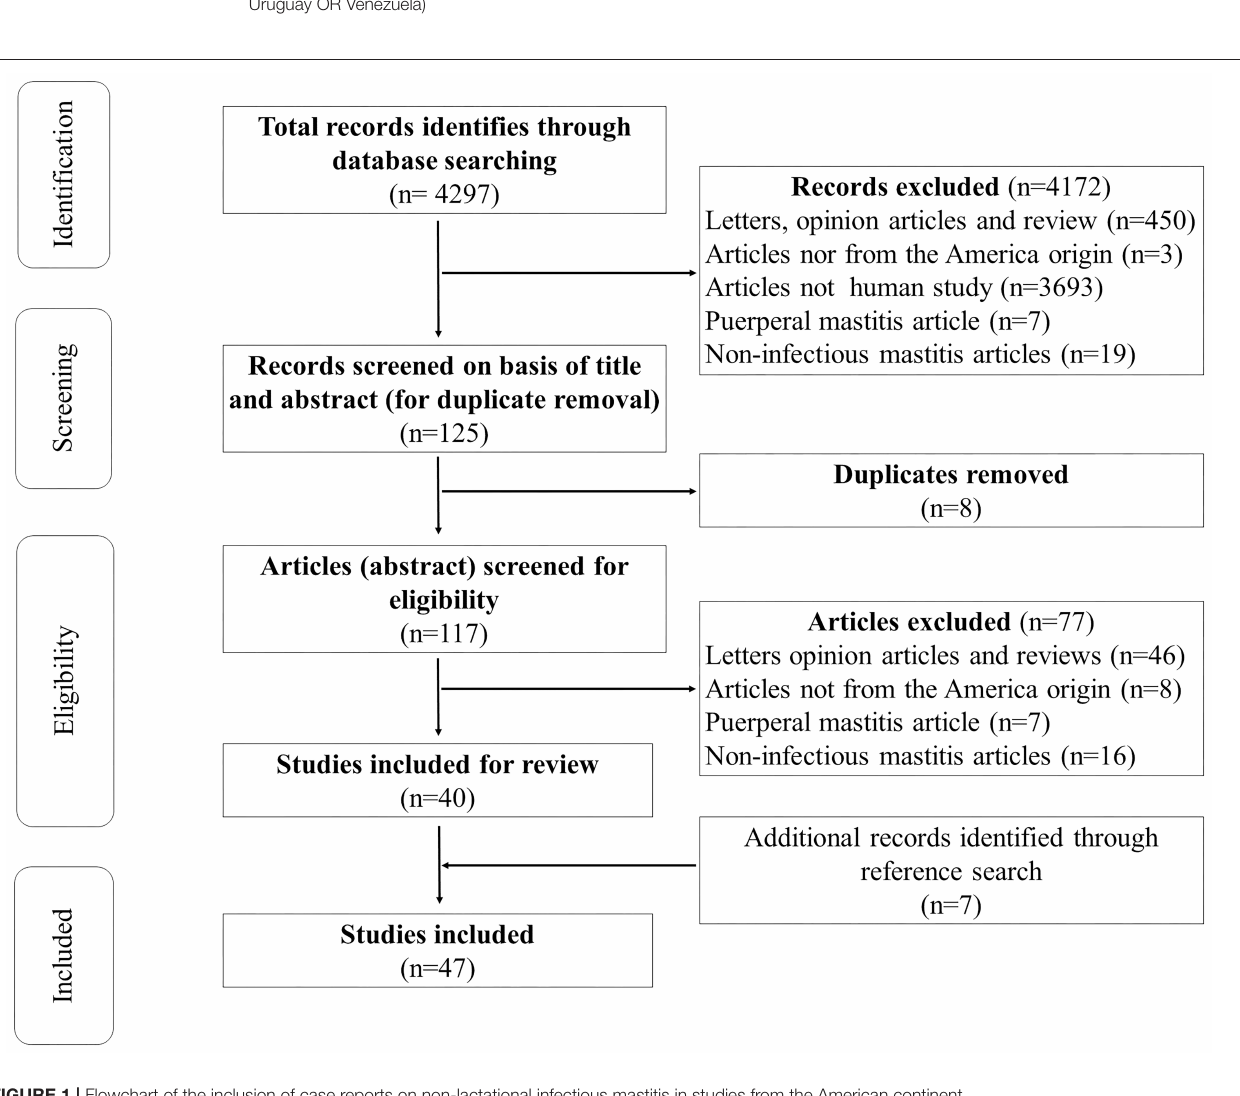
either classified as BI-RAD IV or BI-RAD V (shown in Table 3